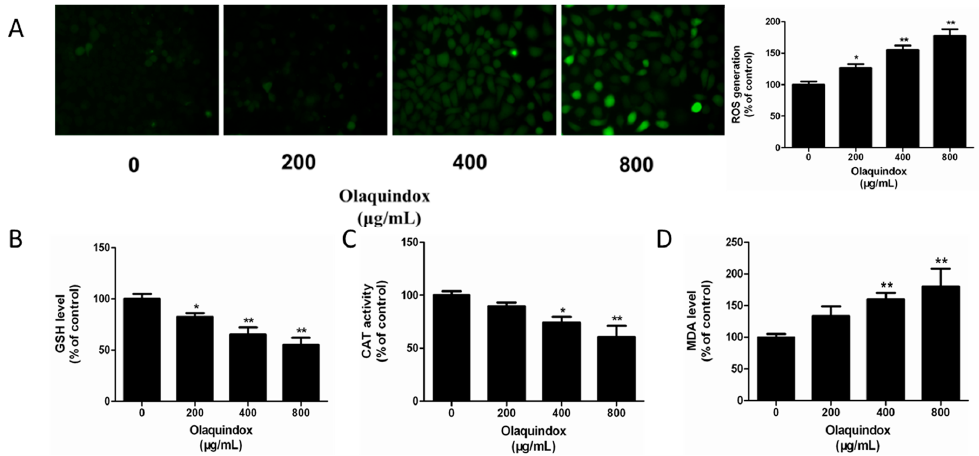
Figure 2. Effects of olaquindox on ROS generation and oxidative stress in HEK293 cells. Cells were treated with specified concentrations of olaquindox for 24 h. ( A ) Intracellular ROS production was measured by 2,7-dichlorofluorescein diacetate (DCFH-DA) and observed under a Leica inverted fluorescence microscope (400×). ROS produced relative to control were quantified; ( B – D ) Effect of olaquindox treated on GSH levels, CAT activities and MDA levels, respectively. All data represents means ± SD from three independent experiments. * p < 0.05, ** p < 0.01, compared to the control group.